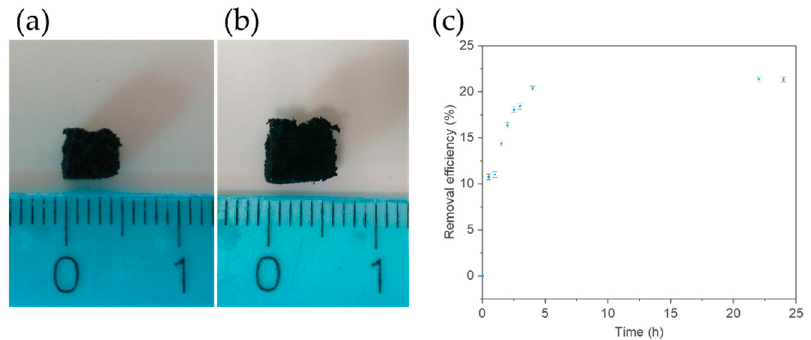
Figure 1. A piece of polydimethylsiloxane/oxidized multiwalled carbon nanotubes (PDMS/oxMWCNTs) sponge ( a ) before and ( b ) after dipping in an olive mill wastewater (OMW) solution. ( c ) Effect of contact time on adsorption of OMW phenolic compounds (PCs) on the PDMS/oxMWCNTs sponge.